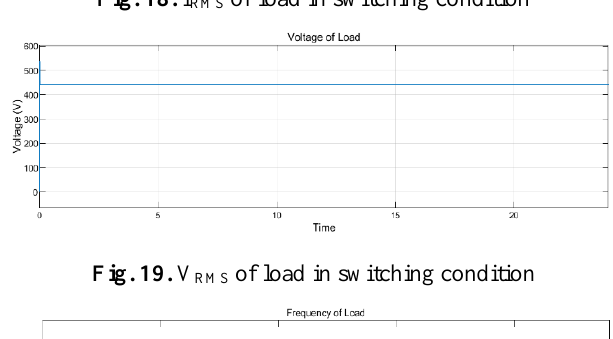
Fig. 18. I RMS of load in switching condition